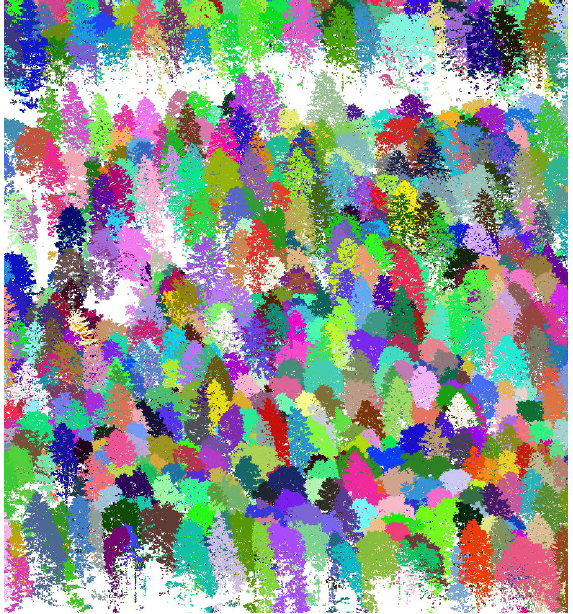
Figure 2. Exemplary single tree segments resulting from the Ncut segmentation; random color